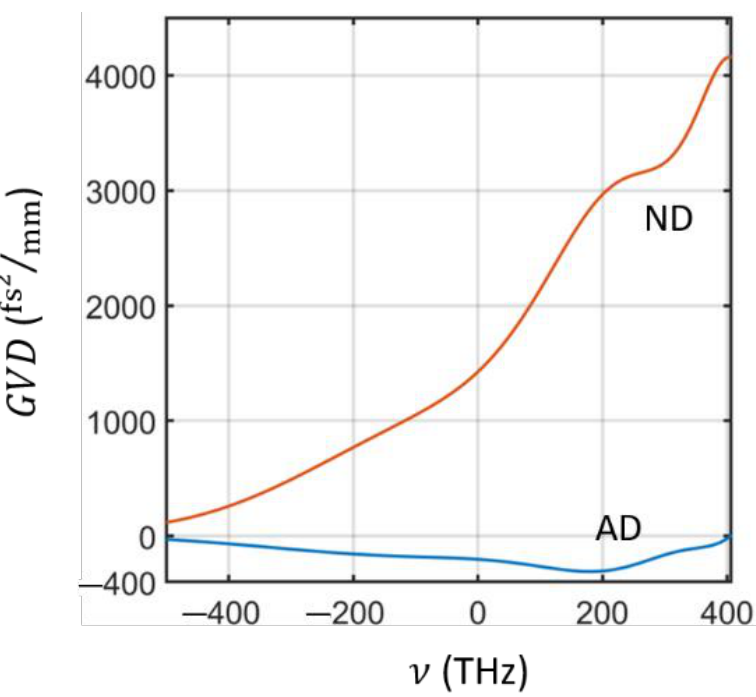
Figure 6. Group velocity dispersion versus angular frequency of the pulse envelope for both the ND segments (red) and AD segments (blue) of the Silicon Nitride sign-alternating dispersion waveguide. The zero frequency is the reference frequency of 1.55 µ